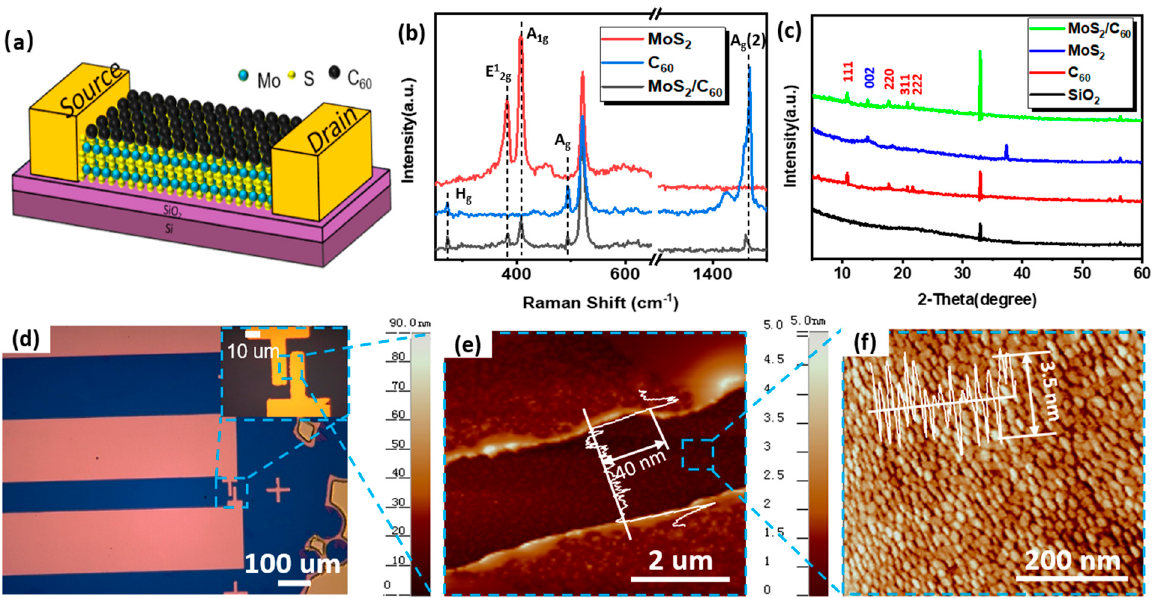
Figure 1. ( a ) Structure diagram of MoS 2 /C 60 heterojunction nanolayer FET; ( b ) Raman characteriza- tion spectrum of 90c-MoS 2 , 120s-C 60 , 90c-MoS 2 -120s-C 60 ; ( c ) XRD characterization of SiO 2 substrate, 90c-MoS 2 , 120s-C 60 , 90c-MoS 2 -120s-C 60 ; ( d ) Optical microscope diagram of FET device; ( e ) AFM diagram of FET device channel area; ( f ) AFM diagram of 90c-MoS 2 -120s-C 60 -FET device